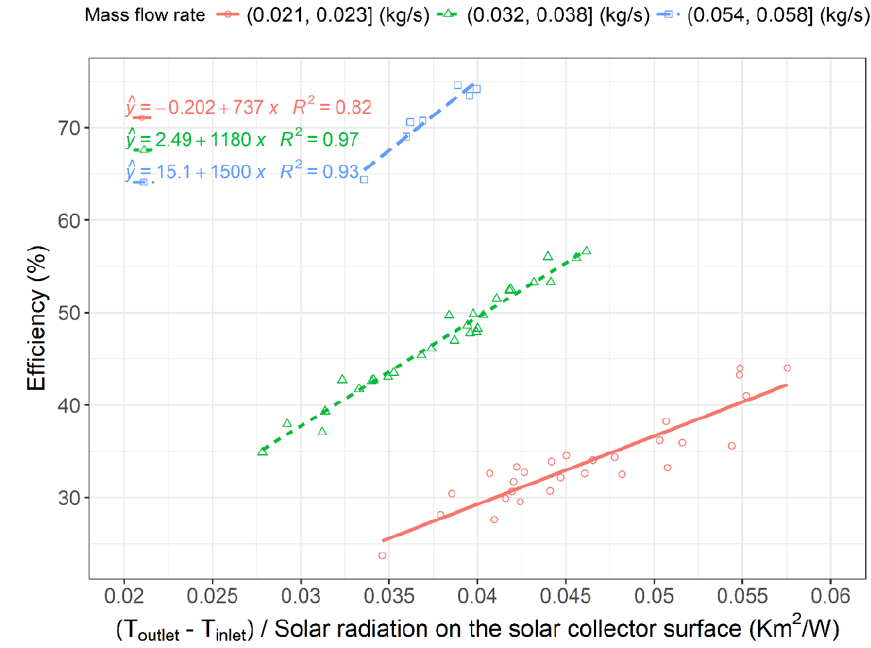
Figure 5. E ffi ciency of the solar air heater versus the value of the e ffi ciency function at di ff erent air Figure 5. Efficiency of the solar air heater versus the value of the efficiency function at different air mass flow rate. The e ffi ciency function is the temperature di ff erence between outlet air (T outlet ), and mass flow rate. The efficiency function is the temperature difference between outlet air (T outlet ), and inlet air (T inlet ) divide the solar radiation on the collector panel (I T ). inlet air (T inlet ) divide the solar radiation on the collector panel (I T ).